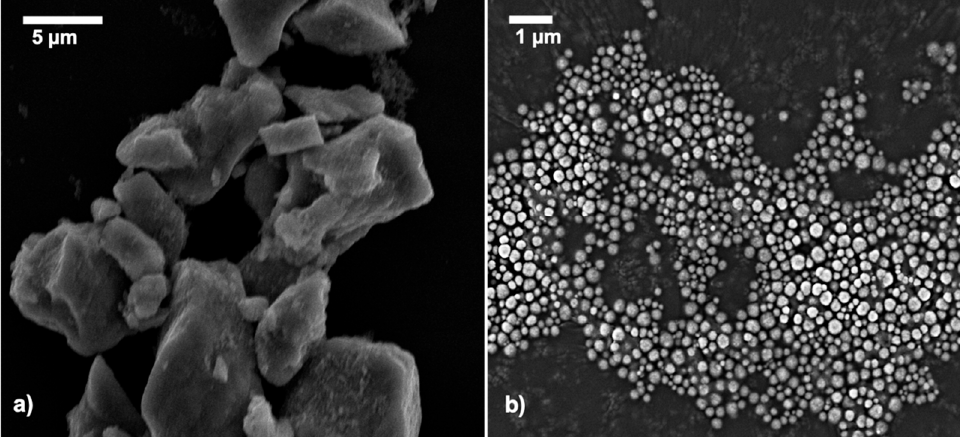
Figure 1. SEM images of MNPs synthesized by ( a ) co-precipitation and ( b ) solvothermal methods (spMNPs).